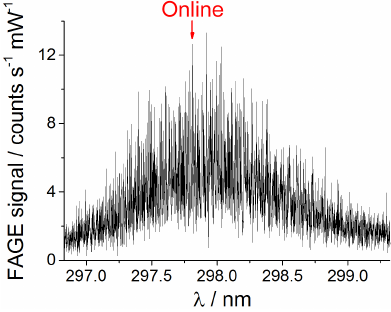
Figure 4. FAGE signal (left axis) and the ratio [CH 3 O] / [CH 3 O 2 ] 0 = 3) ← X 2 E Figure 2. Laser excitation spectrum of the A 2 A 1 ( ν (cid:48) 3 (right axis) as a function of the concentration of NO for a reaction = 0) transition of the methoxy radical. CH ( ν (cid:48)(cid:48) 3 O radicals were 3 time of 3ms. Black squares are experimental CH 3 O signals (errors obtained by photolysis of methanol in N 2 at 184.9nm. Fluo- are 1 σ) and red circles are the ratio [CH 3 O] / [CH 3 O 2 ] 0 generated rescence cell pressure = 2.65 ± 0.05Torr; wavelength increment by numerical simulations (percentage uncertainties are 20%) using (cid:49)λ = 10 − 3 nm, with each point corresponding to 5000 laser shots. the chemistry system outlined in the main text and described in fur- The red arrow indicates the wavelength λ (online) ∼ 297.79nm used ther detail in the for the time-resolved kinetic studies of CH 3 O 2 .